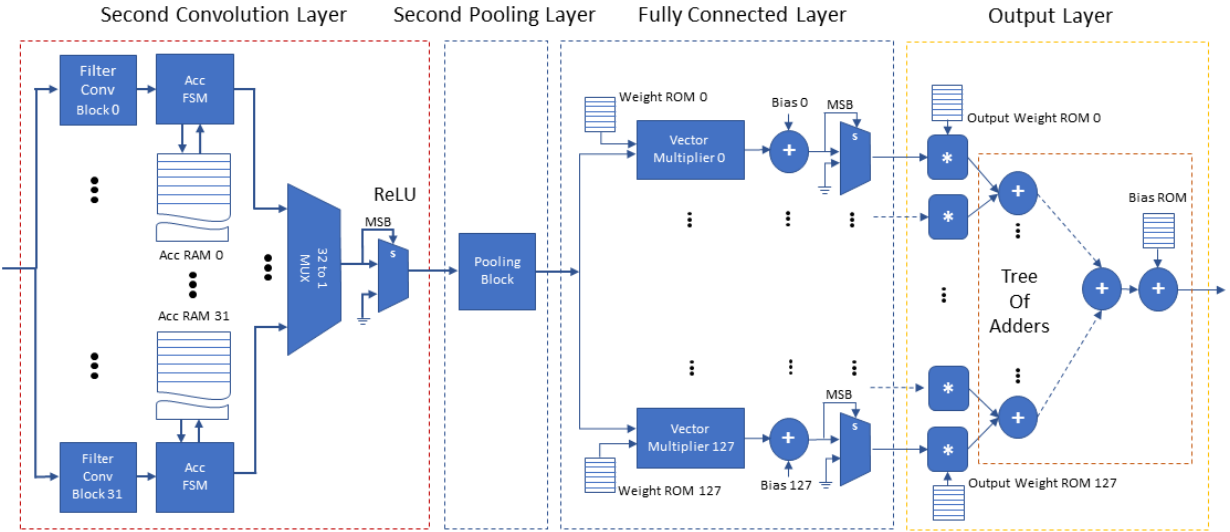
Figure 7. FPGA architecture of the second convolution and pooling layers, fully connected layer and output layer ( ∗ refers to fixed-point integer multiplication, s refers to the “select” input pin of the multiplexer, + refers to fixed-point integer